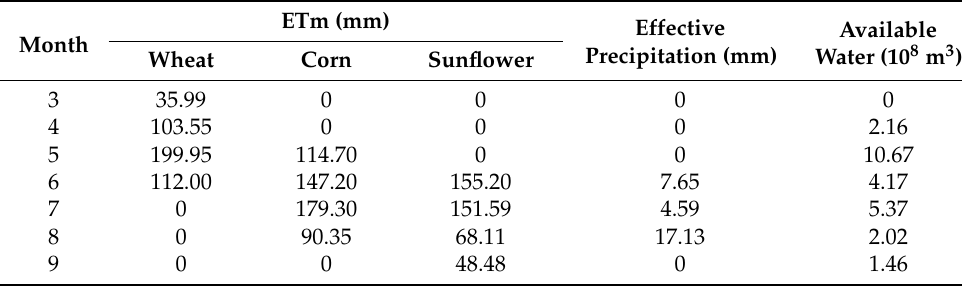
Table 3. Meteorological and hydrological data of Hetao Irrigation District.